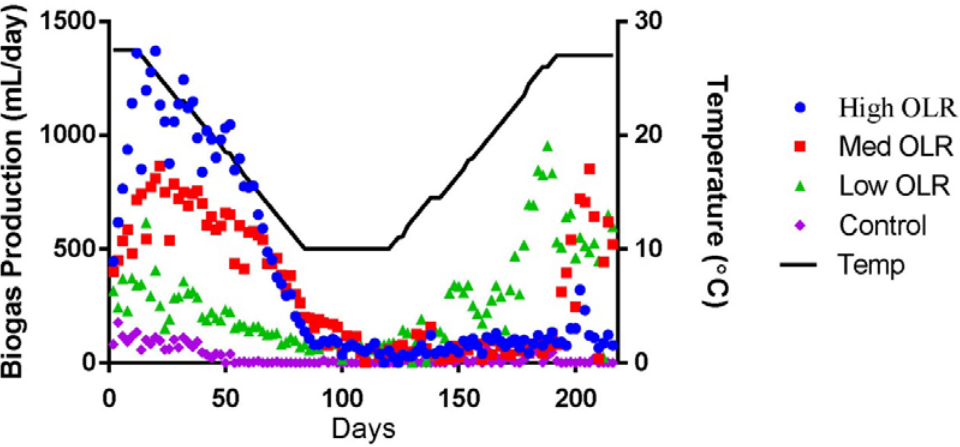
Figure 1. Average daily biogas production (mL) for the four different digester